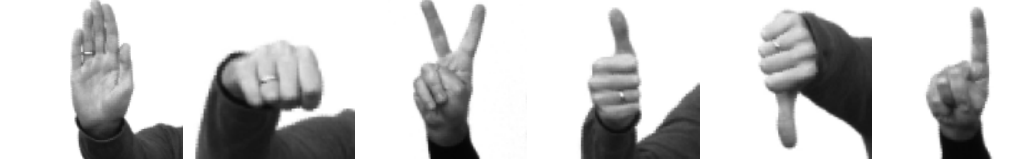
Figure 26. Hand poses (static gestures).